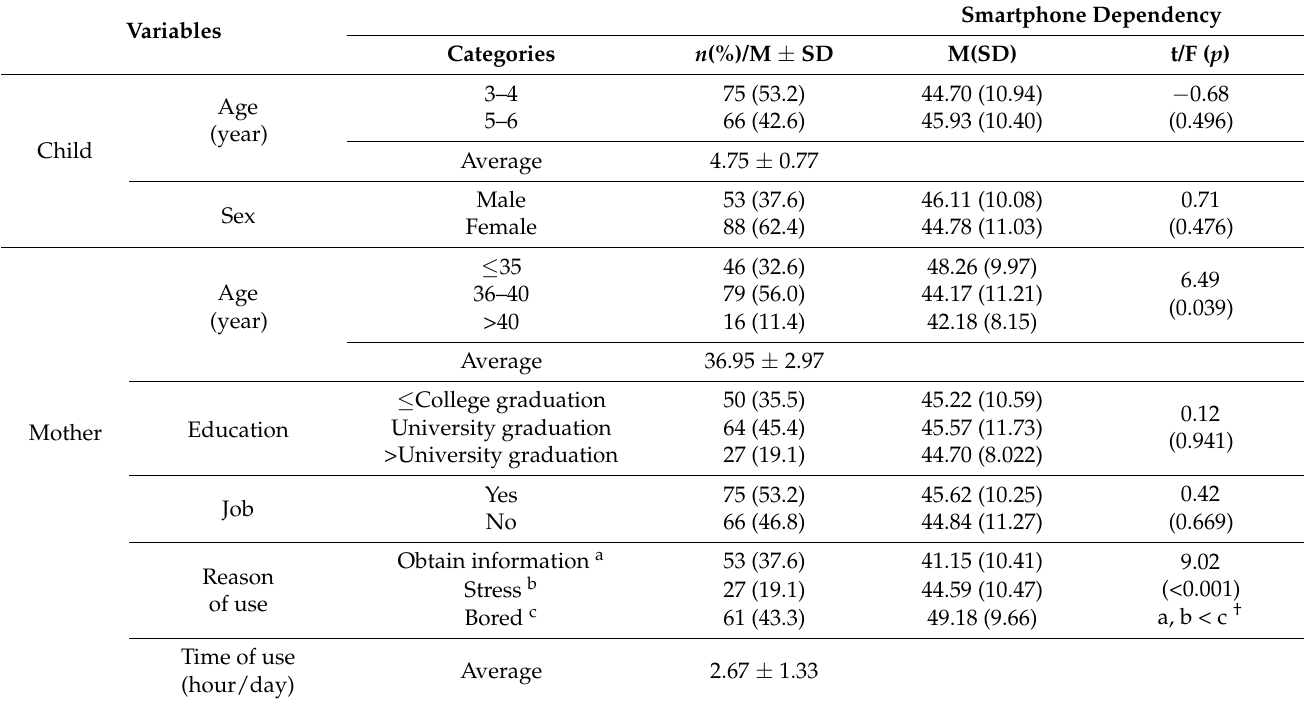
Table 1. Smartphone dependency according to general characteristics. ( n = 141).